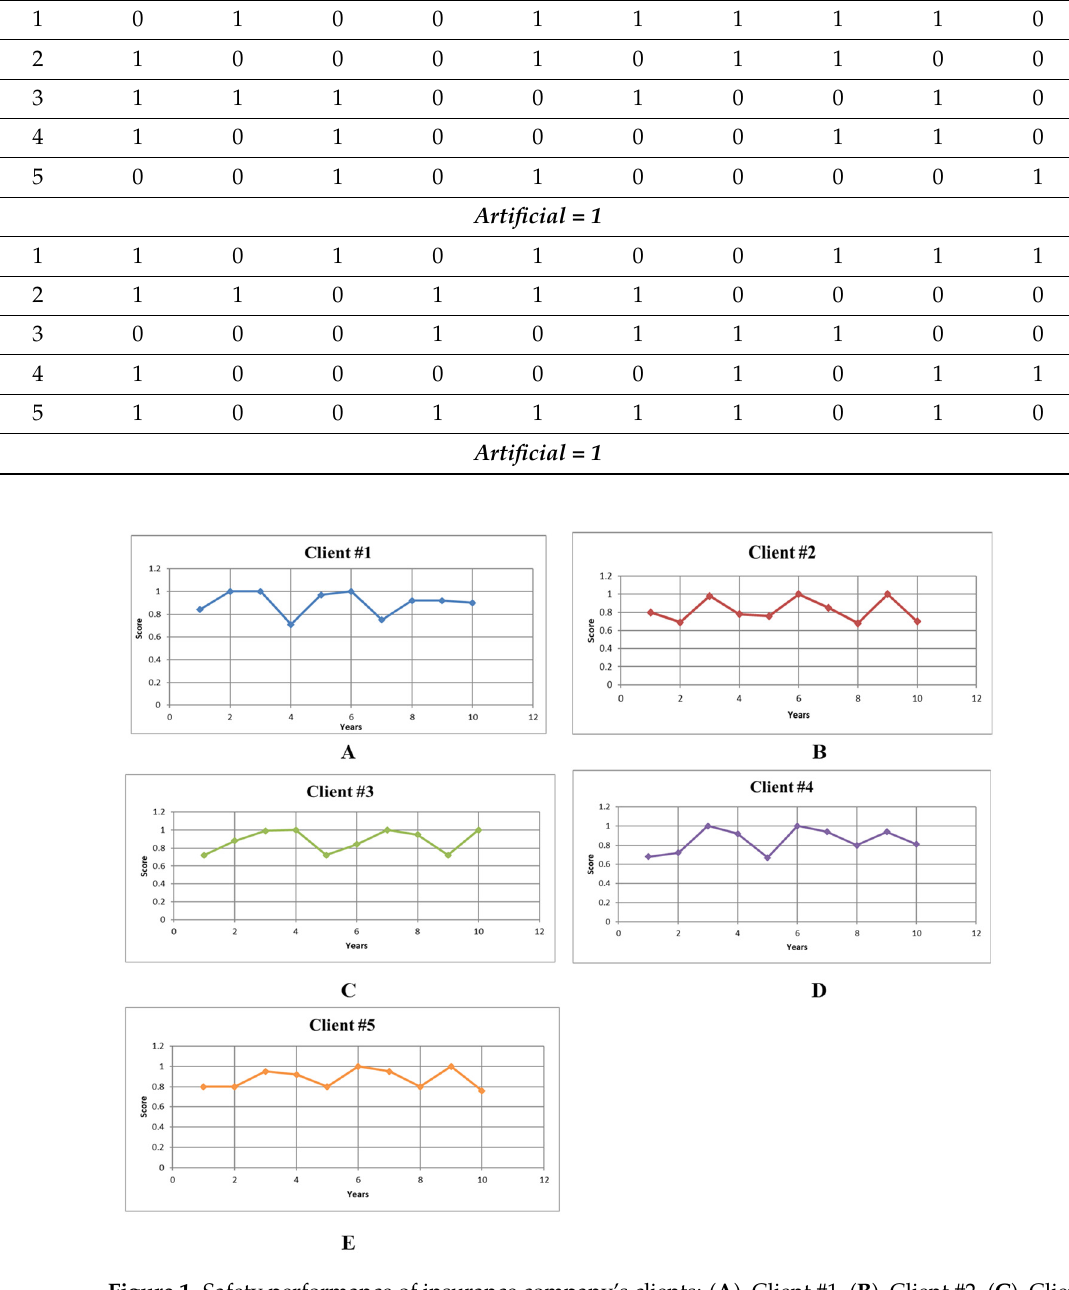
Figure 1. Safety performance of insurance company’s clients: ( A ). Client #1, ( B ). Client #2, ( C ). Client #13, ( D ). Client #4, and ( E ). Client #5. Table 2. The 10 ‐ year criteria values of an insurance company’s clients.